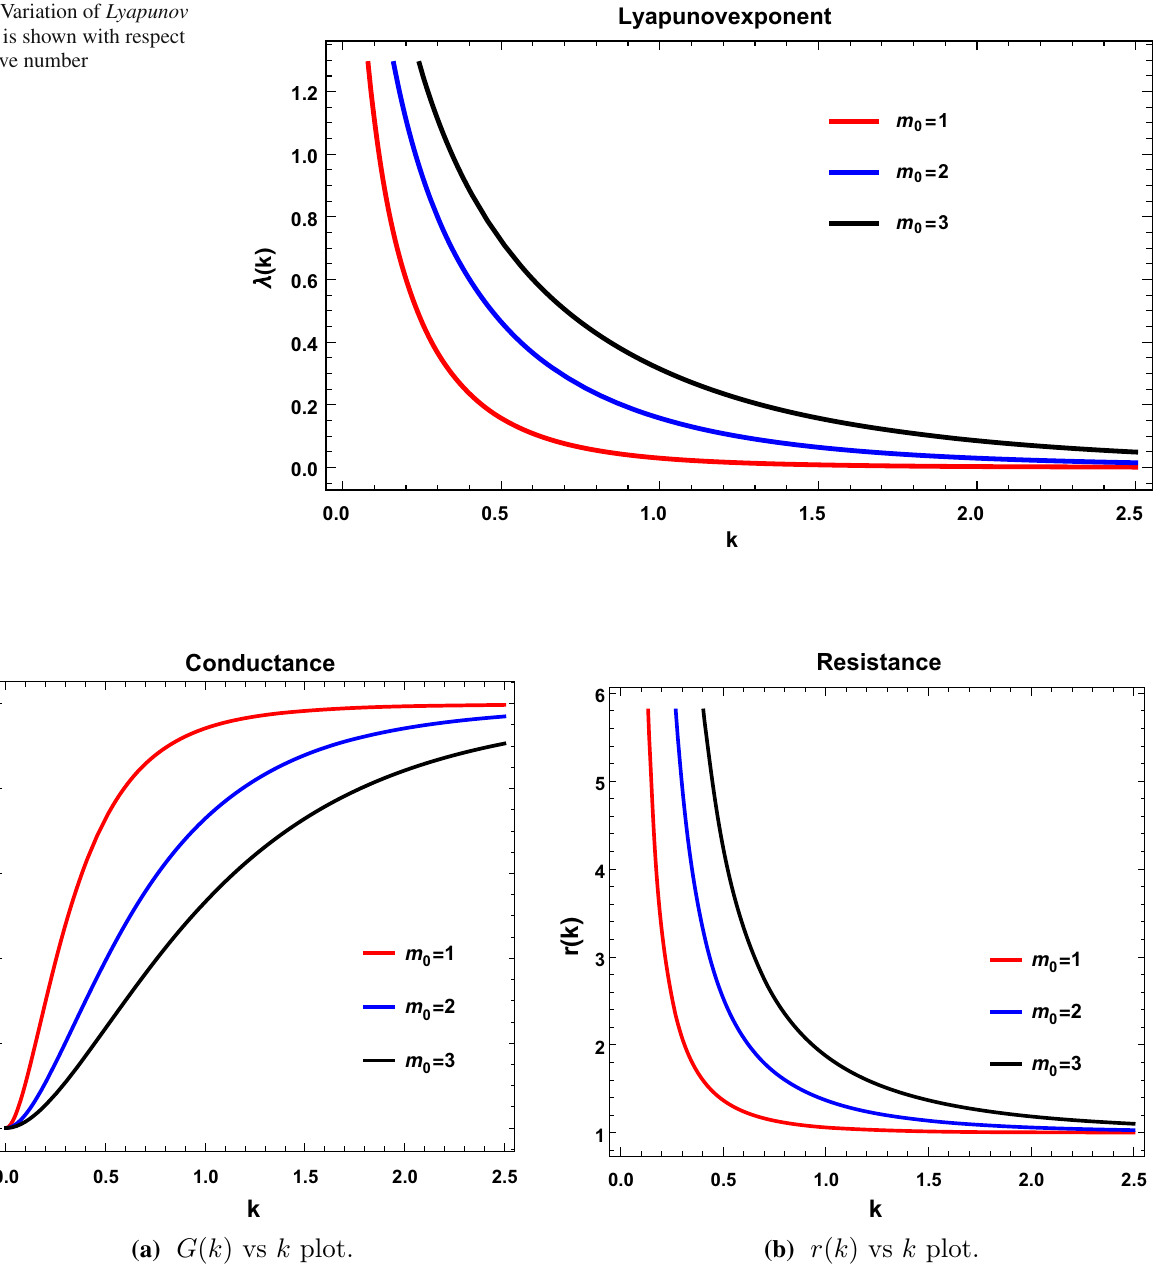
Fig. 18 Variation of Lyapunov exponent is shown with respect to the wave number